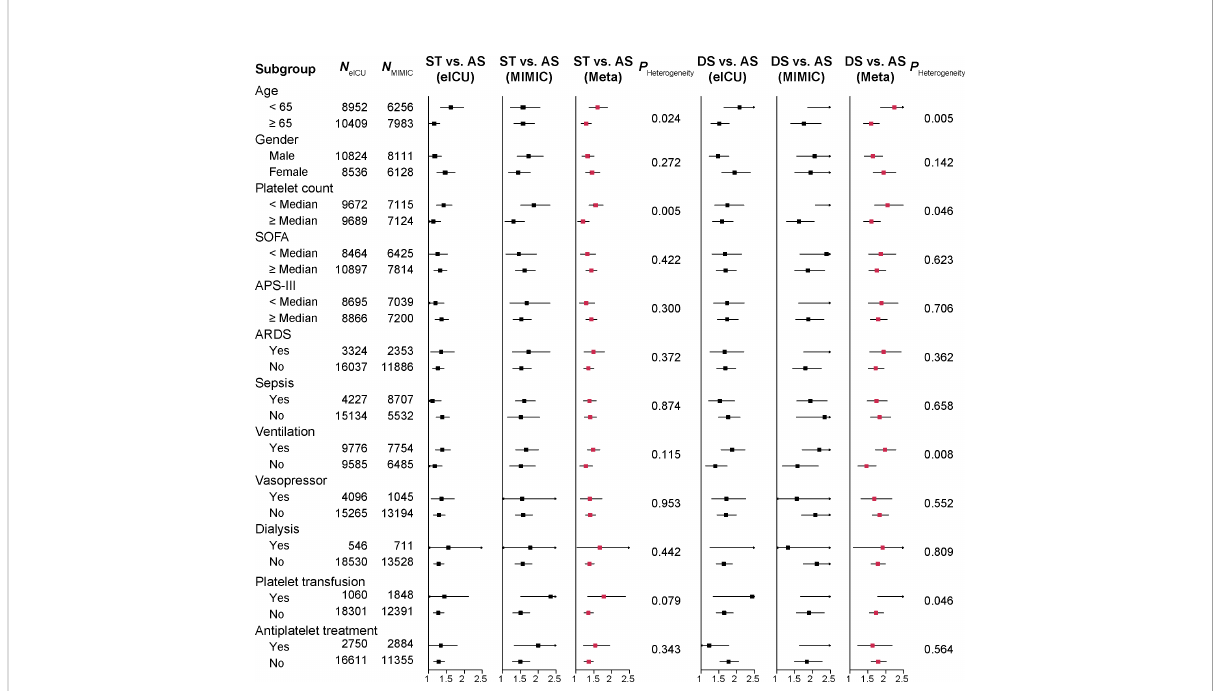
FIGURE 2 Forest plots of strati fi ed associations between platelet count trajectory patterns and 28-day survival of ICU patients. Meta-analysis was conducted to pool the results from the eICU-CRD and MIMIC-IV databases. The effects across strata were tested using heterogeneity